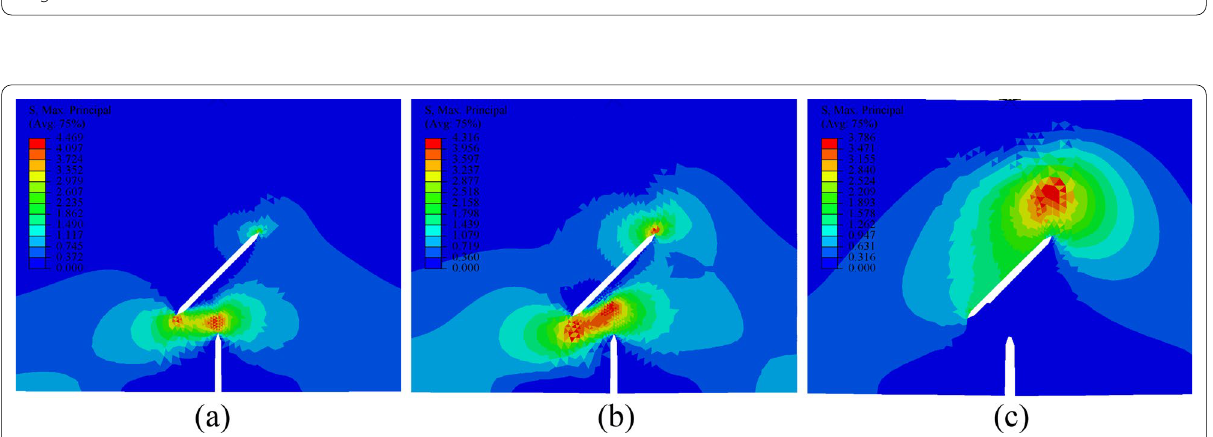
Fig. 10 Evolution of maximum principal stress distribution of TPB‑A45‑T2 during the fracture processes: ( a ) crack initiation, ( b ) crack intersection, and ( c ) instability